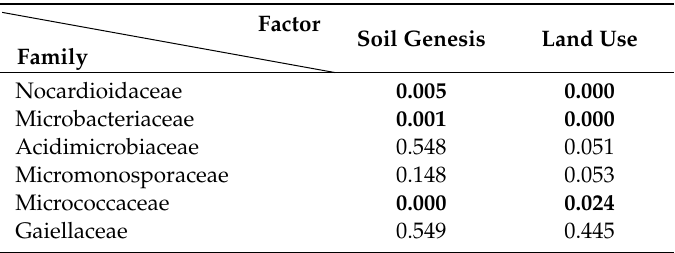
Table A2. E ff ect of soil genesis and mode of land use on the abundance of the most representative families of Actinobacteria. The e ff ects are represented as p -values of two-way ANOVA. Bolded values indicate significant e ff ects.